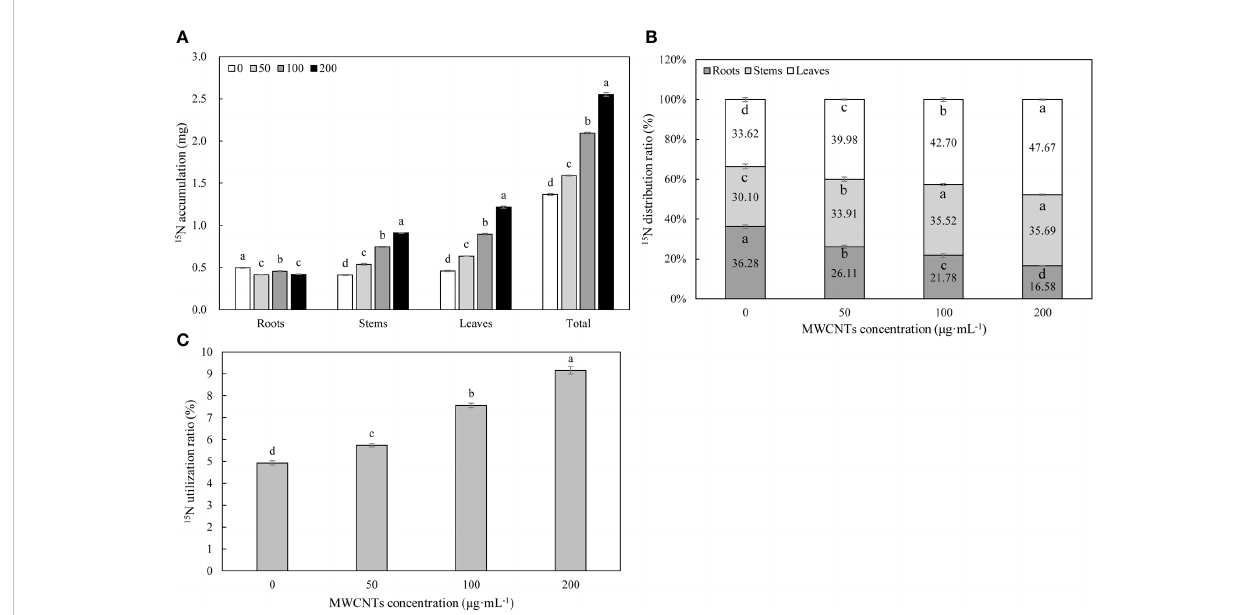
FIGURE 3 15 N-KNO 3 accumulation (A) and distribution ratio (B) in each organ, and seedlings under the 0, 50, 100, and 200 µg·mL -1 MWCNTs treatments for 30 days. Different lowercase letters indicate signi fi cant difference at P < 0.05, and error bars represent the standard deviation of the mean (One-way ANOVA,